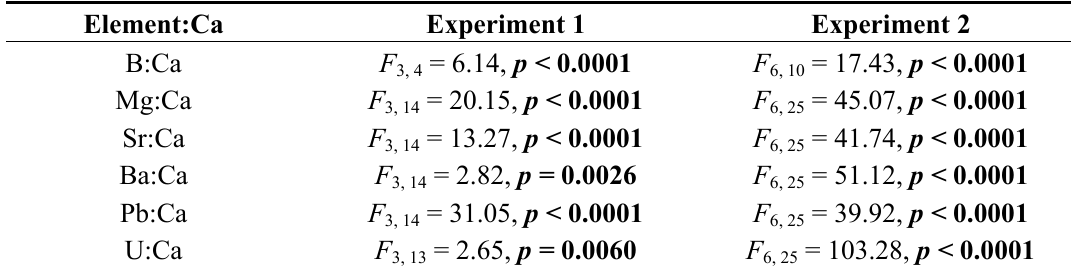
Table 2. The statolith elemental:calcium composition among capsules within treatments was tested using a one-way mixed model ANOVA (nested within treatment and tank factors). Significance =